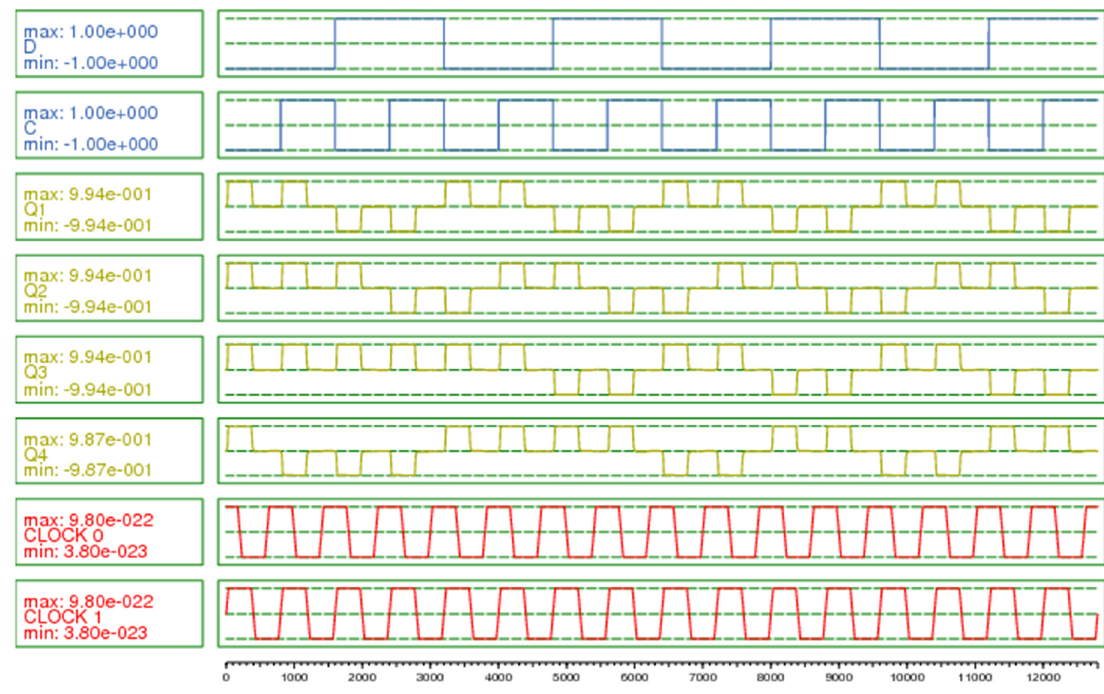
Figure 21. Simulation graph of 4-bit SIPO shift register.